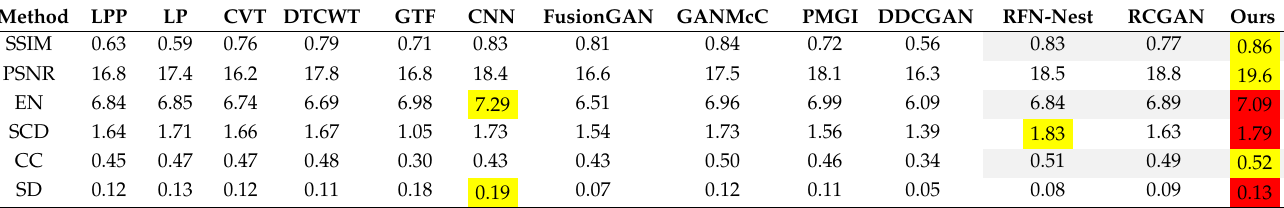
Table 2. Quantification results for our proposed method and state-of-art fusion methods (the best value is marked in yellow, and the second-best value is marked in